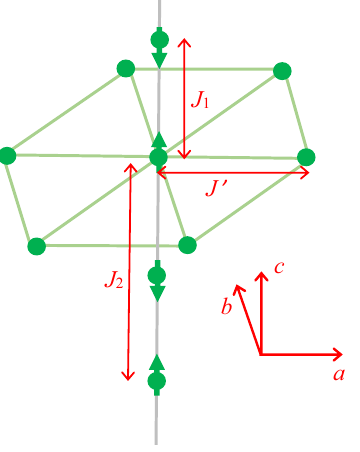
Figure 1. Schematic of crystal structure of RbCoCl 3 , showing the Co ions only (filled green circles) ordered antiferromagnetically along chains (in the crystallographic c direction) with nearest-neighbour exchange J 1 and next nearest-neighbour exchange J 2 . Each Co ion is surrounded by a hexagon of six Co ions with interchain exchange interaction J’ in the a-b